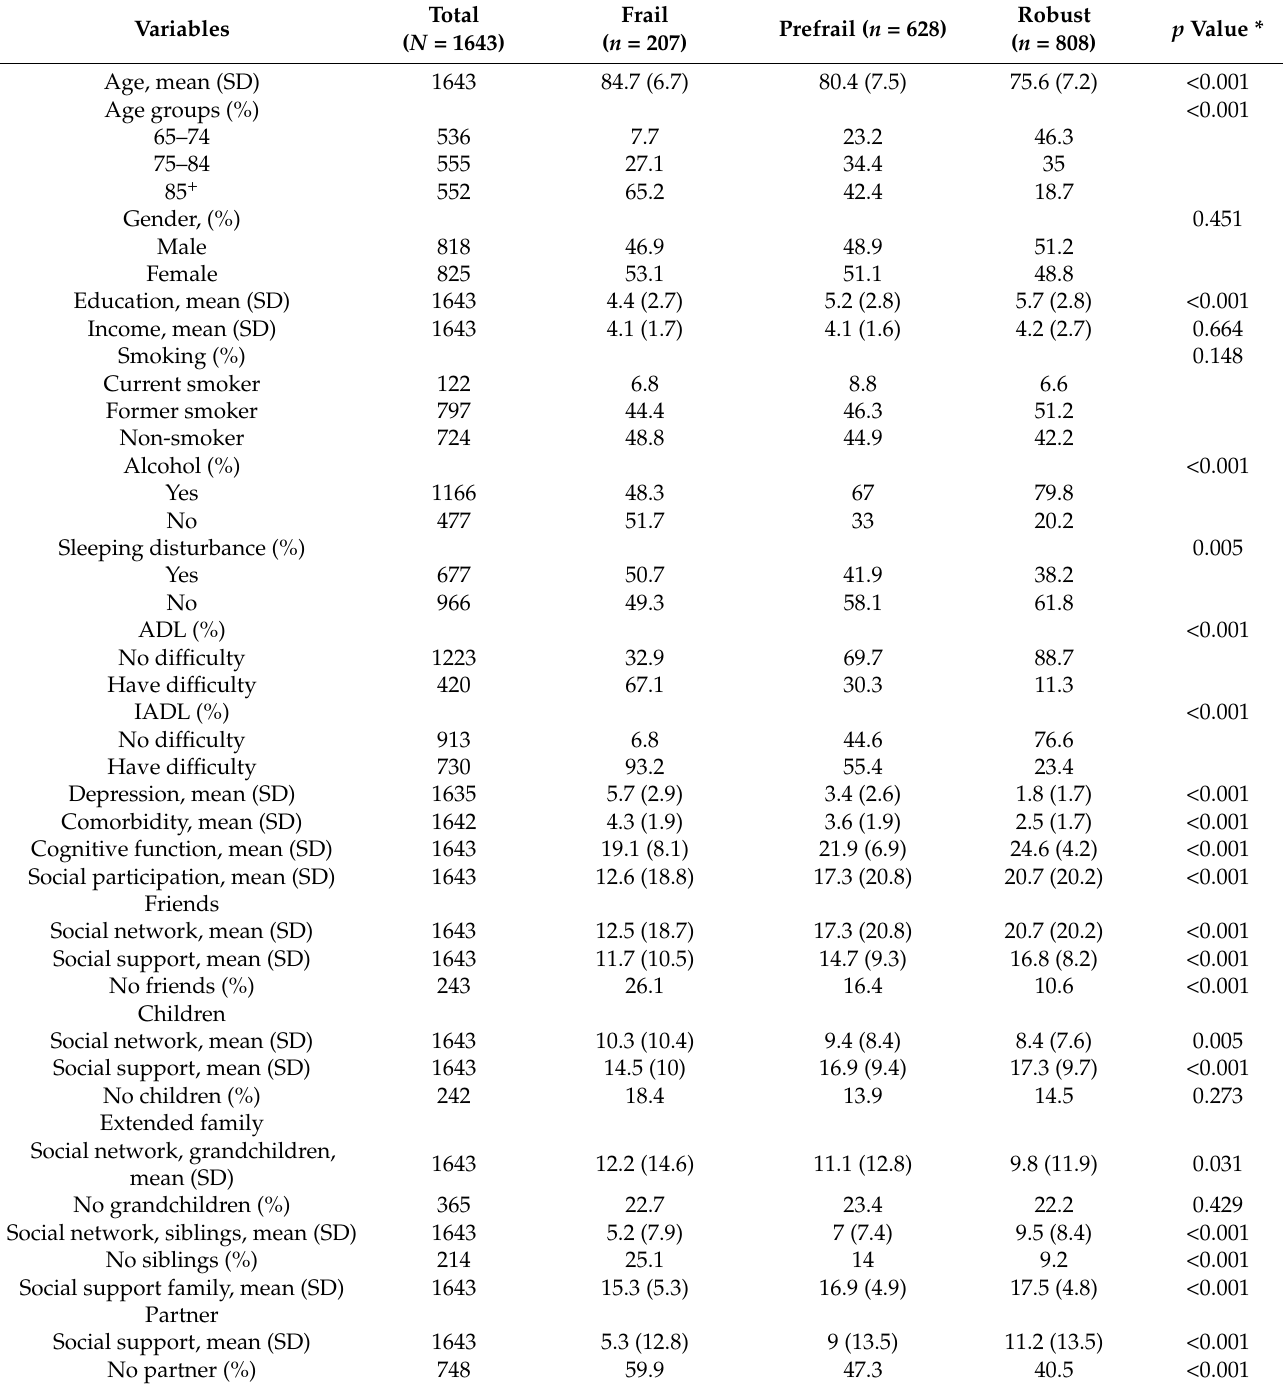
Table 1. Characteristics of the participants by frailty status.